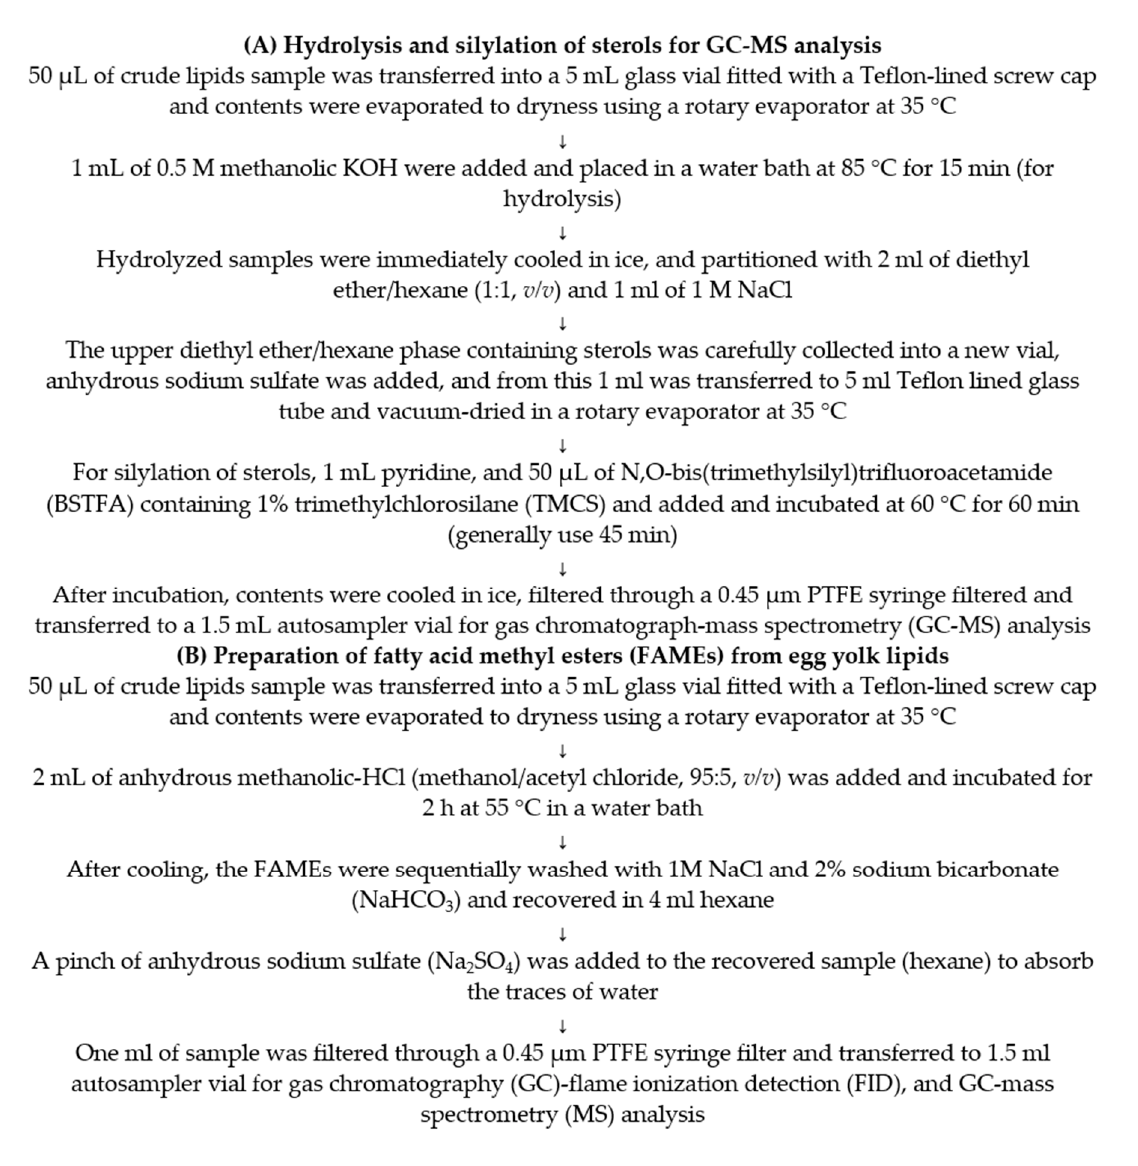
Figure 2. ( A ) Method for hydrolysis of crude lipid extract for sterol analysis and ( B ) the preparation of fatty acid methyl esters